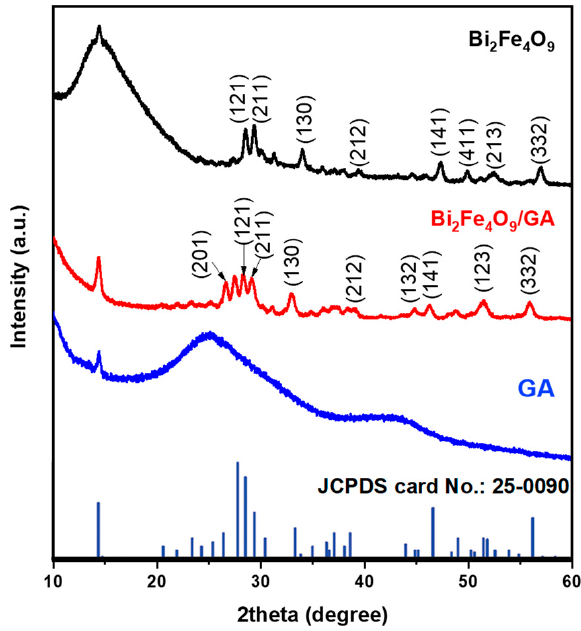
Figure 1. XRD patterns of GA, Bi 2 Fe 4 O 9 and Bi 2 Fe 4 O 9 /GA.